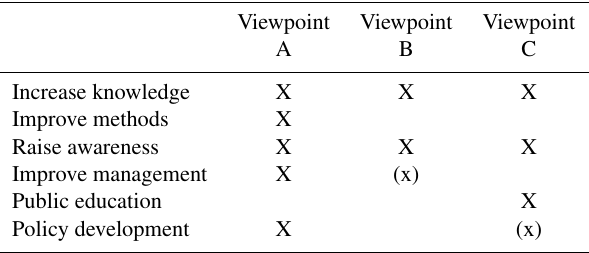
Table 4. Overview of Theme III (purposes for citizen science) as supported in Viewpoints A, B and C. Purposes clearly indicated are marked with an X. (x) indicates that support for this purpose is not convincing. Viewpoint Viewpoint Viewpoint A B C